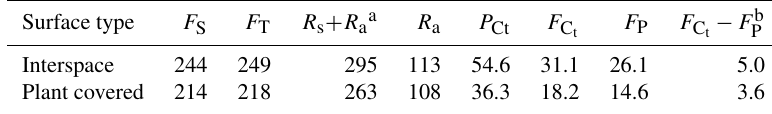
Table 3. Simulated component CO 2 fluxes (gCm − 2 yr − 1 ) for areas with plant cover and without (interspace). Surface type